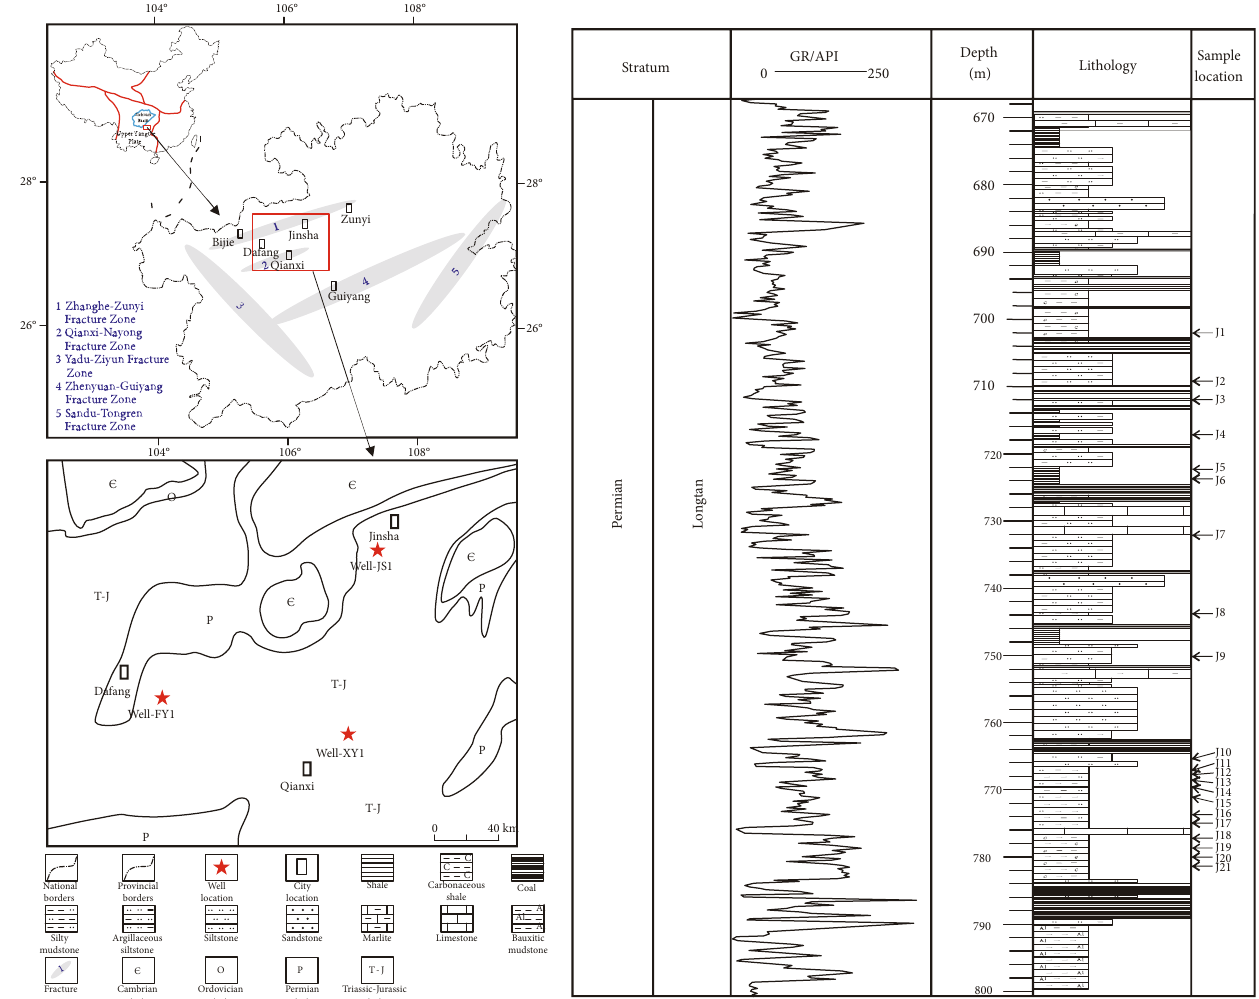
Figure 1: Geological background of the research area and stratigraphic column of the Longtan